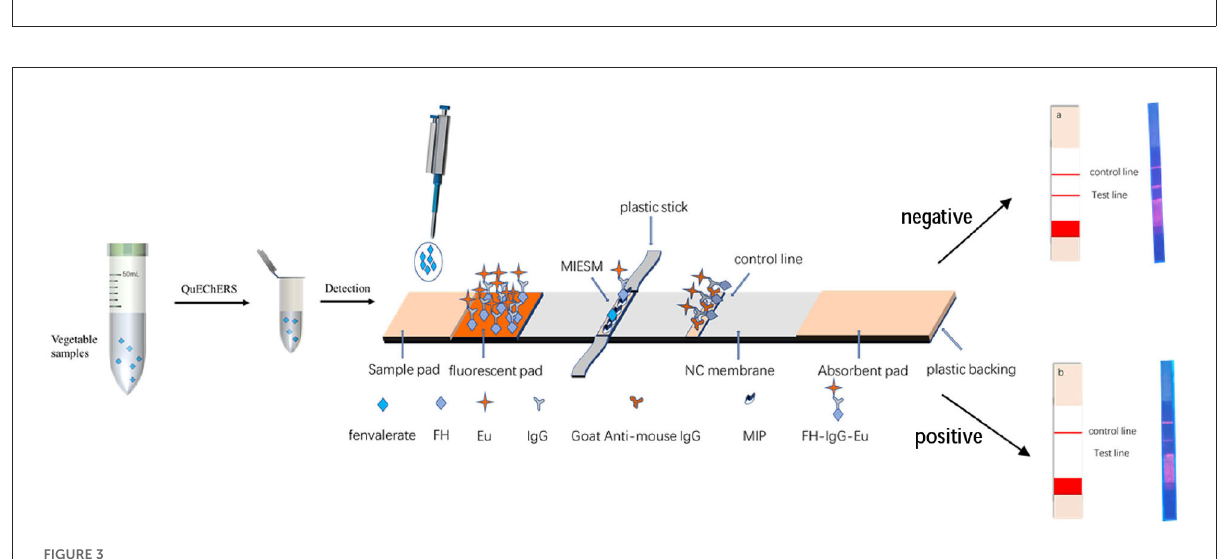
FIGURE3 Detection